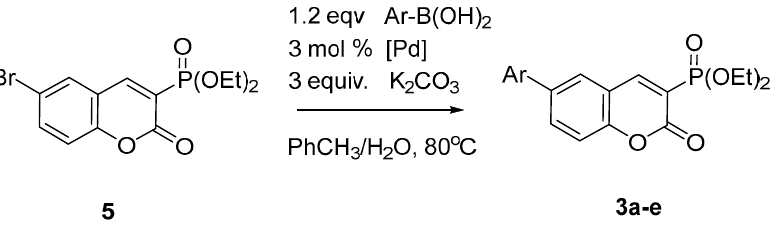
Table 3. Parameters, reagents, and products of palladium-catalyzed arylation of 6-bromo-3-phosphonocoumarin 5 .